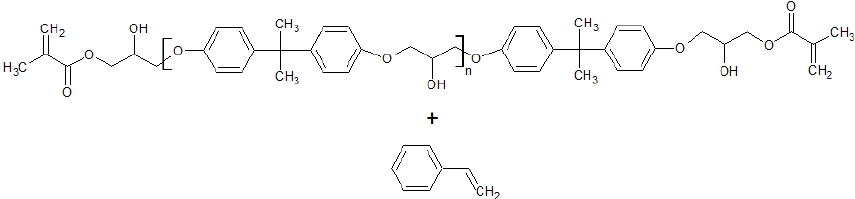
Figure 3. Vinyl-ester resin before cross-linking [22].